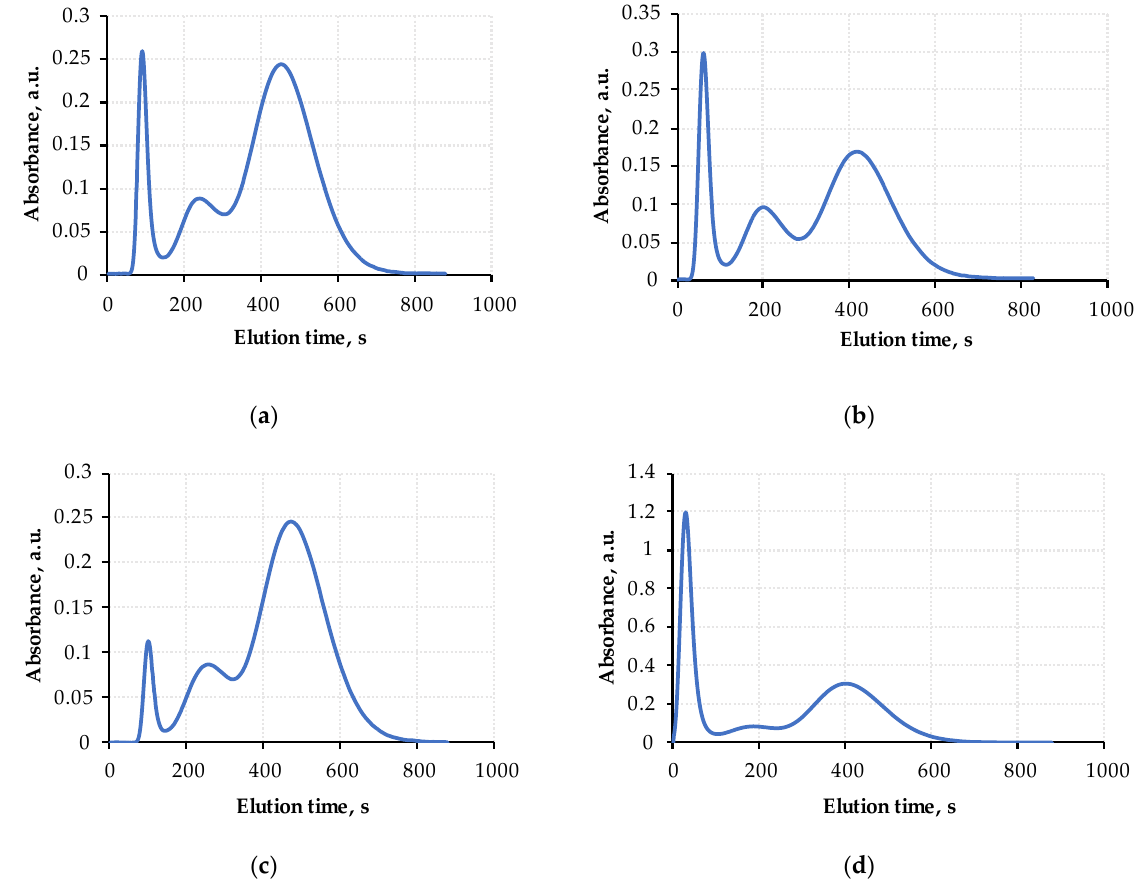
Figure 5. Chromatogram of peritoneal dialysate samples with varying total protein contents taken from four CAPD patients: ( a ) Average protein and uric acid; ( b ) Average protein, low uric acid; ( c ) Low protein, average uric acid; ( d ) Abnormally high protein, average uric acid.